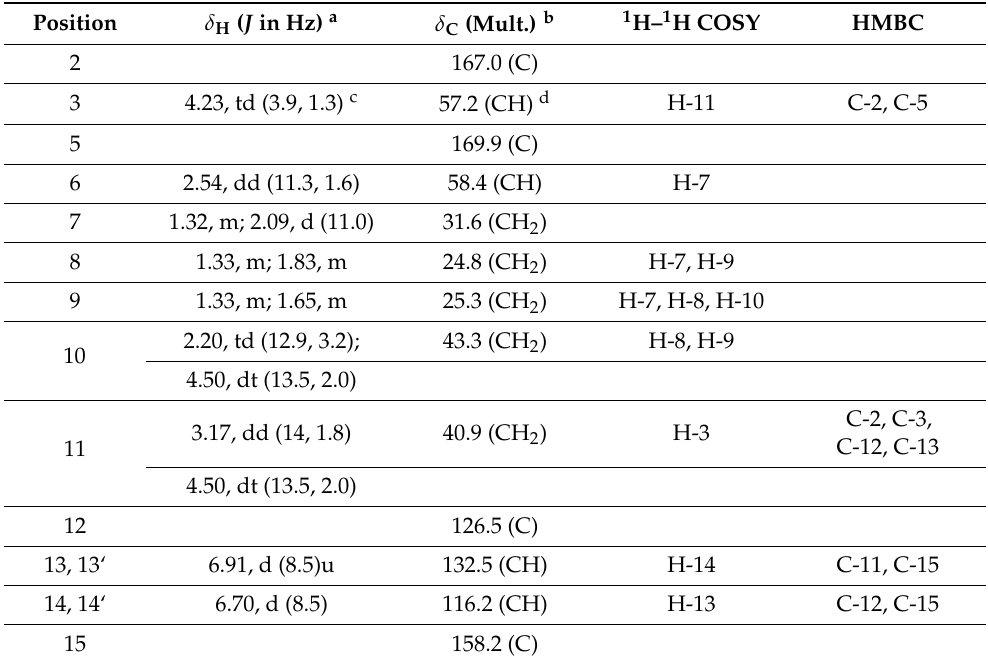
Table 1. 1 H (500 MHz, CD 3 OD) and 13 C (125 MHz, CD 3 OD) NMR data for 1 .